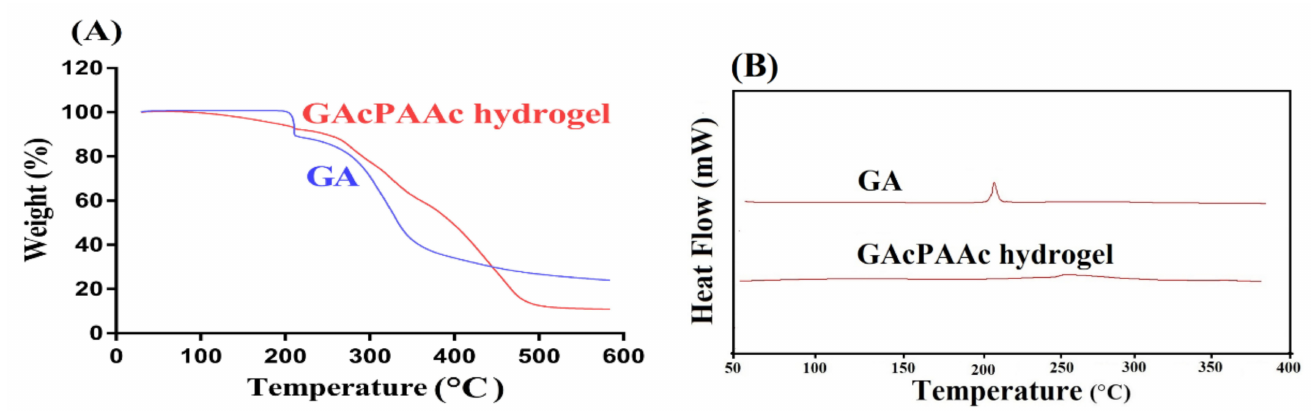
Figure 3. ( A ) TGA and ( B ) DSC of GA and GAcPAAc hydrogel. Differential scanning calorimetry (DSC) analysis is carried out for unreacted GA and GAcPAAc hydrogels as indicated in Figure 3B. GA exhibits an endothermic peak at 198 ◦